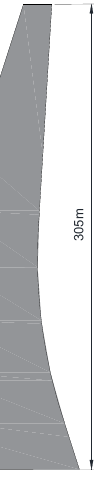
Figure 13. Positions of detonation for various media.